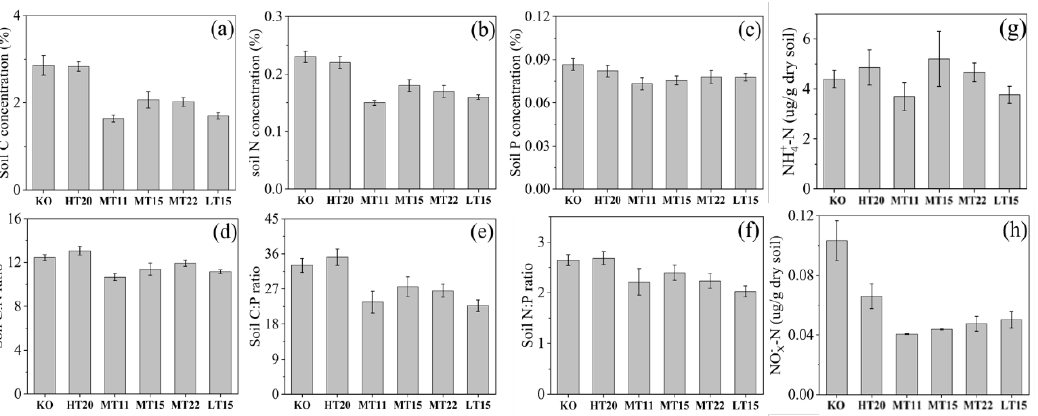
Figure 2. Soil concentrations of ( a ) C, ( b ) N and ( c ) P, stoichiometric ratios of ( d ) C:N, ( e ) C:P and ( f ) N:P, as well assoil-extracted ( g ) NH 4+ -N and ( h ) NO 3 − -N concentrations in the Qi’ao mangrove